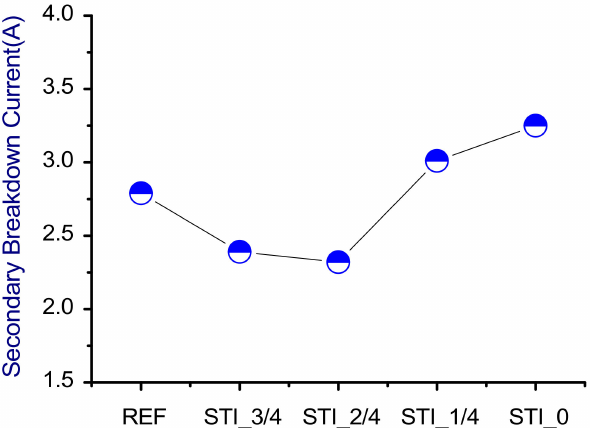
Figure 10. Trigger voltage / holding voltage distribution charts of HV nLDMOSs with drift- region modulation.